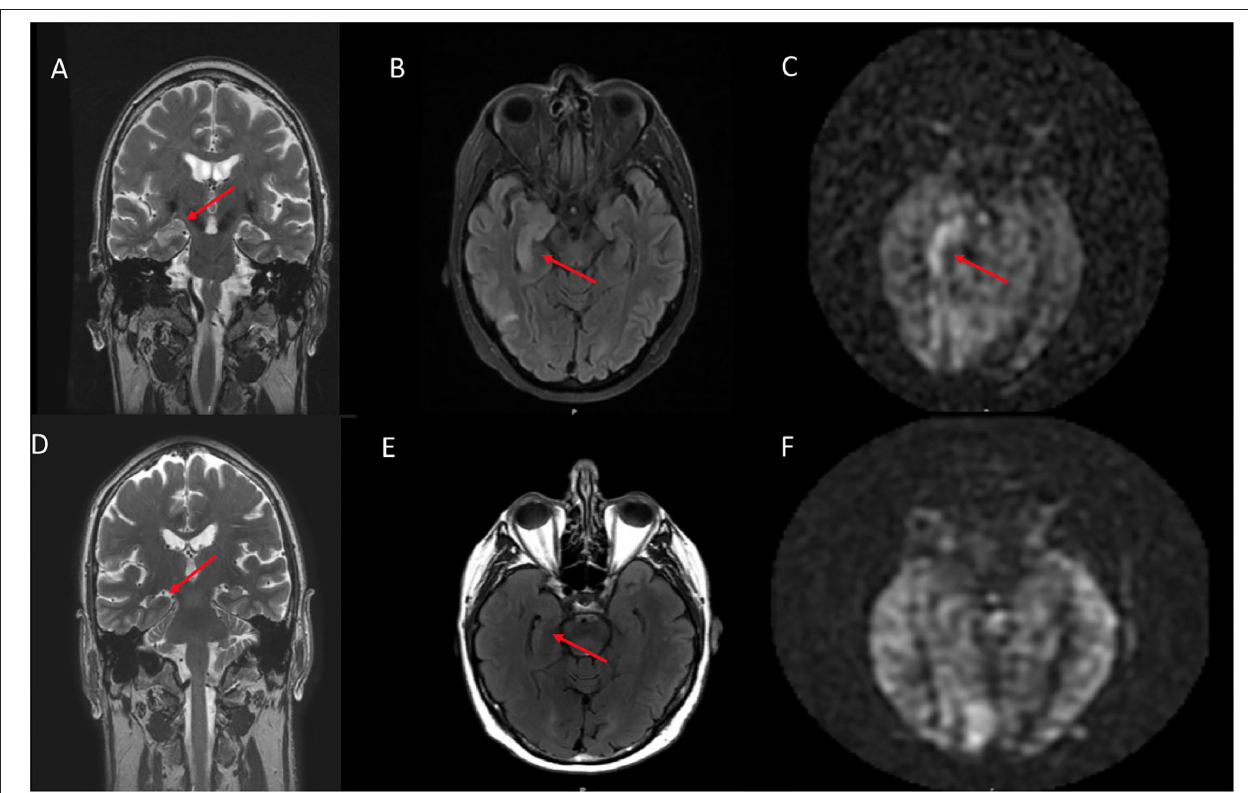
FIGURE 1 | A 70 year old male who presented with rapid cognitive decline and spasmic extremity movement. (A) Initial coronal T2W shows asymmetric T2 hyperintense signal in the right hippocampus. (B) Axial FLAIR demonstrates asymmetric hyperintense signal in the right hippocampus and focal cortical signal abnormality in the posterior right temporal lobe. (C) ASL shows focal hyperperfusion in the right hippocampus and milder asymmetric signal in the posterior right temporal and right occipital lobes. (D) 12 month follow up coronal T2W shows mild right hippocampal volume loss. (E) Follow up axial FLAIR shows mild right hippocampal volume loss and hyperintense signal. (F) Follow up ASL shows complete resolution of the previously right hippocampal hyperperfusion. Of note, the decreased ASL signal in the left occipital lobe is due to the present of an ipsilateral fetal